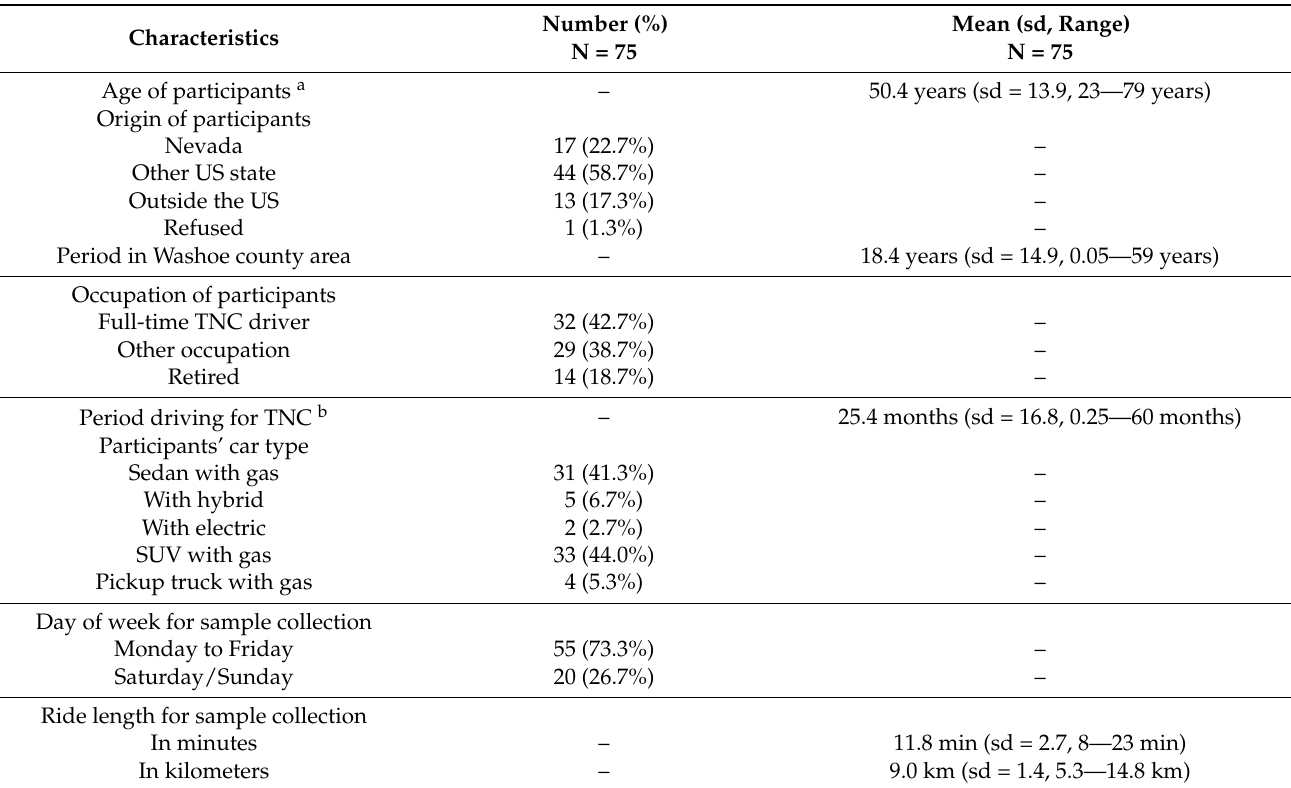
Table 1. Demographics of participants driving for Transportation Network Companies (TNCs) and data